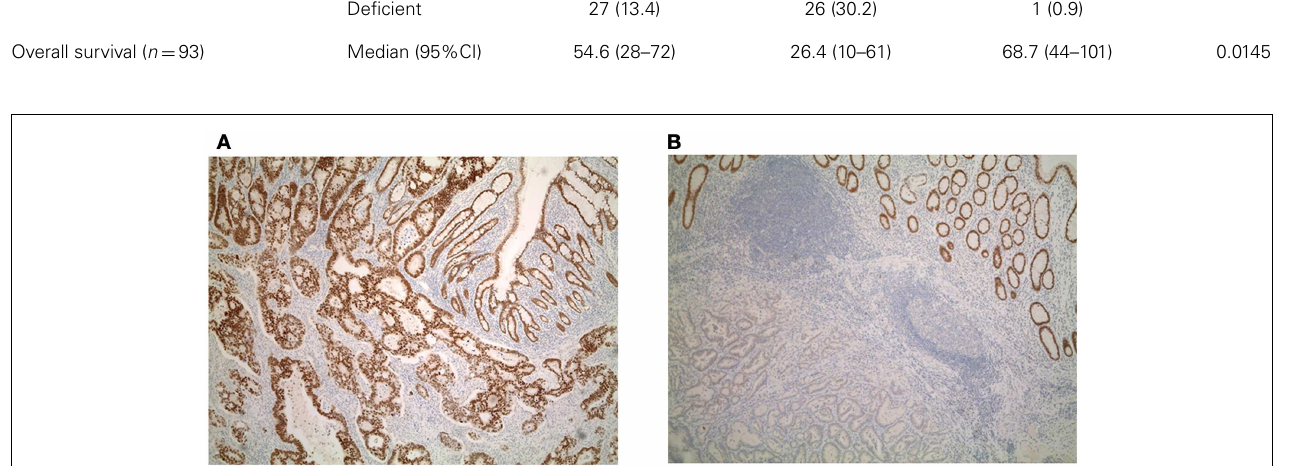
FIGURE 1 | (A) Diffuse and (B) focal expression of Cdx2 in colorectal